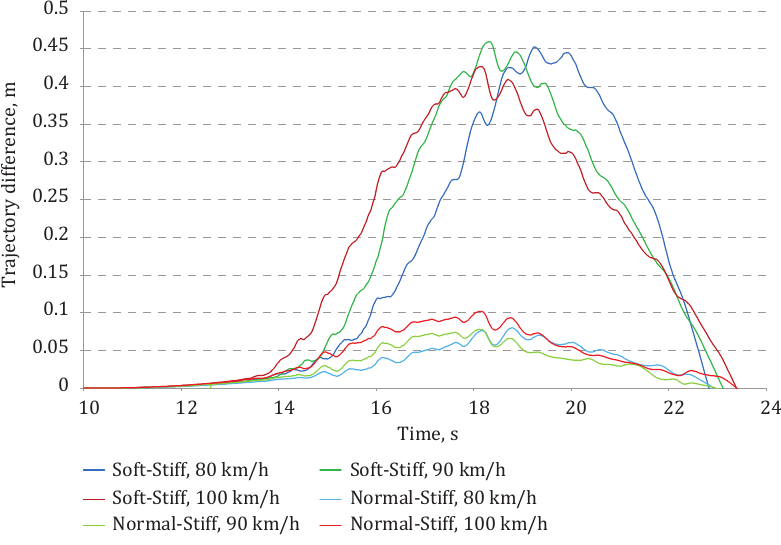
Figure 9. Trajectory differences with different suspension damping modes and driving speeds on E class road for the right